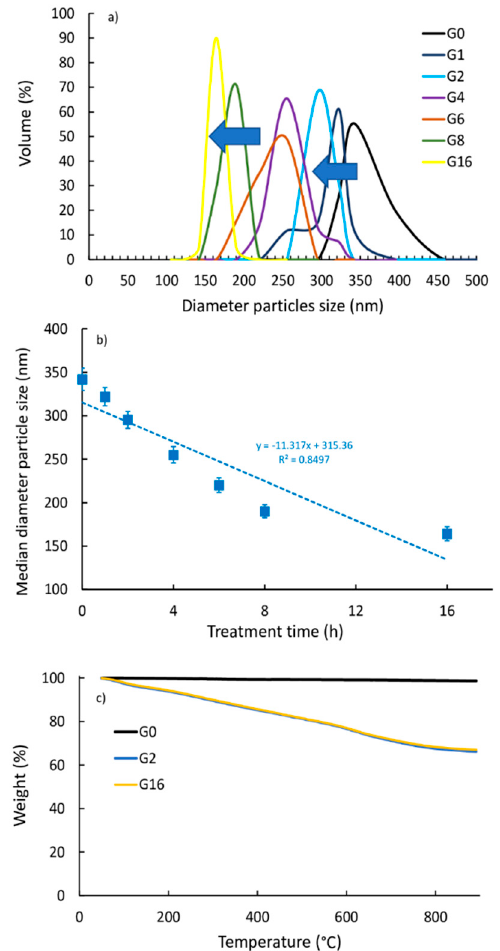
Figure 4. ( a ) Graphite size distribution as a function of treatment time of PE and the nanocomposites with dynamic light scattering (DLS). ( b ) Median diameter particle size vs. treatment time. ( c ) TGA analysis of PE, PE-G2, and